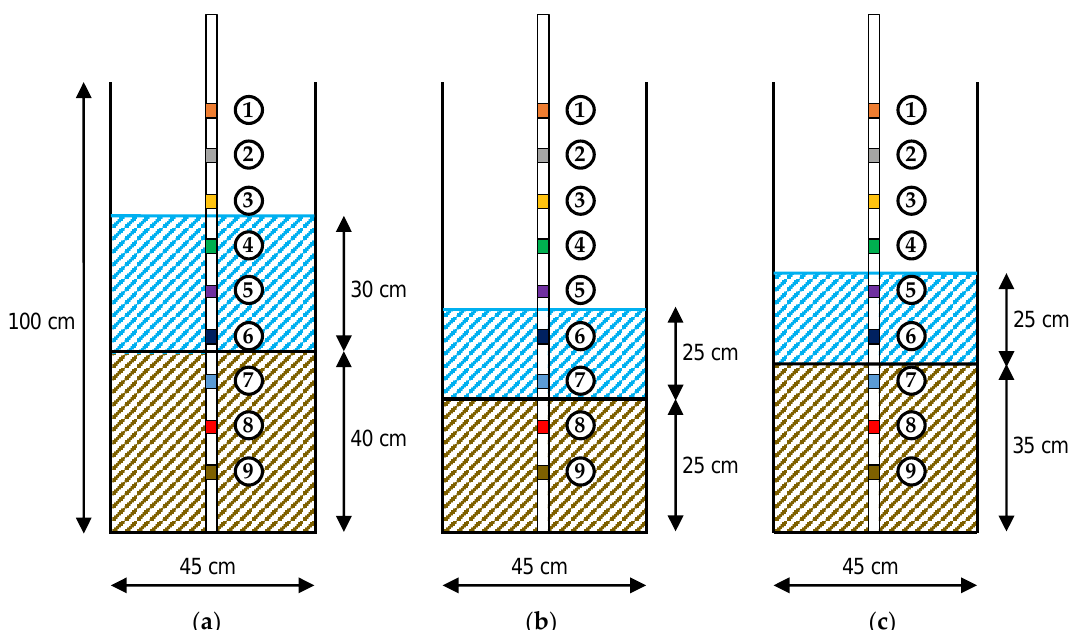
Figure 9. Experimental setup ( a ) the pre-scour, ( b ) the scour, and ( c ) the deposition condition.